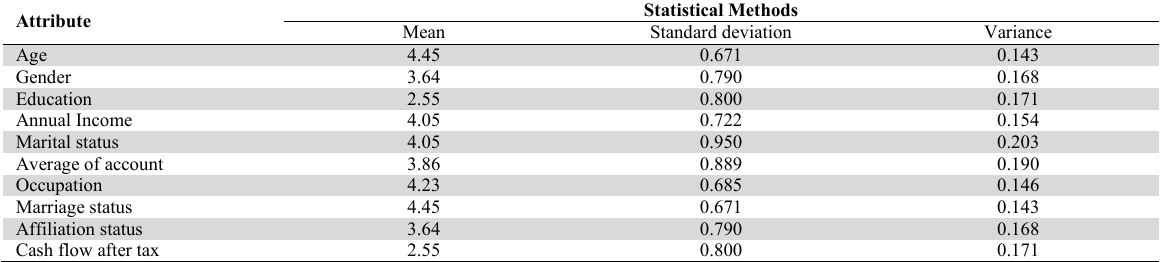
Statistical analysis of data set (bank 5)